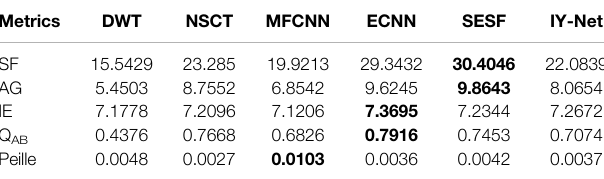
TABLE 4 | Quantitative evaluation results of multi-exposure image fusion.